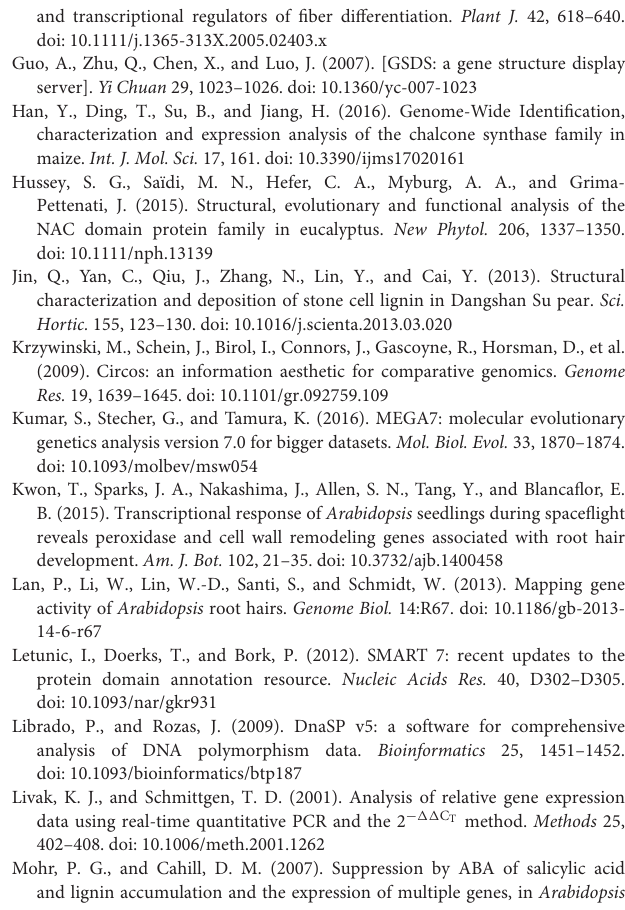
Table S5 | Estimates of the divergence time for pear duplicated PRX paralogs. Table S6 | The ESTs of putative PbPRX